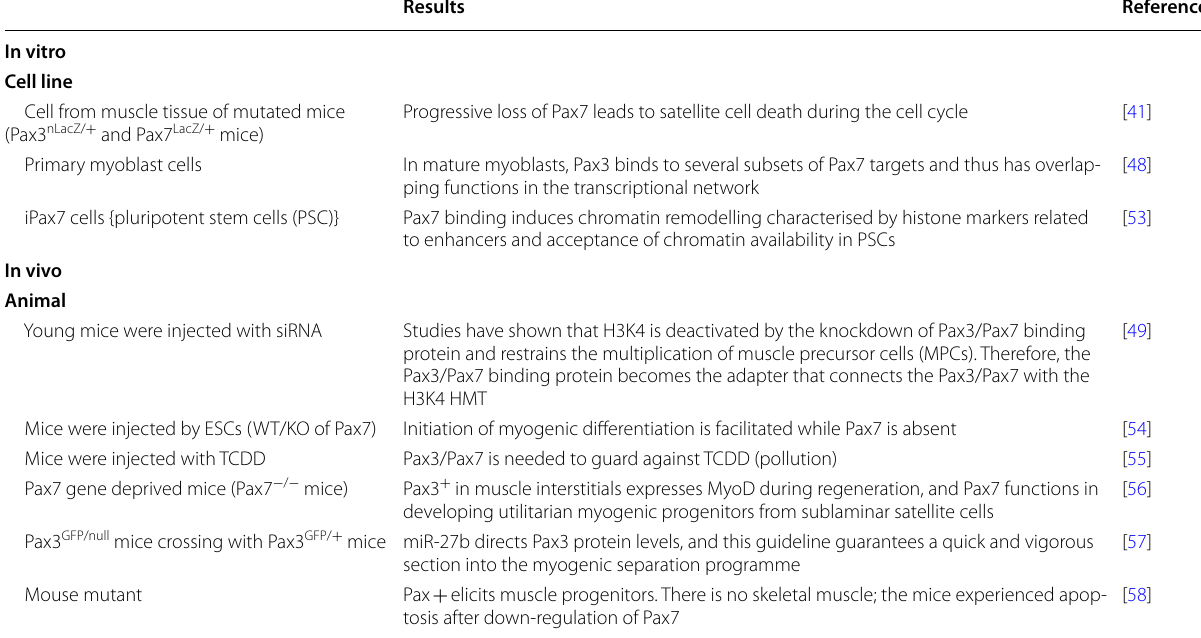
WT Wildtype, KO Knocked-out, TCDD 2,3,7,8-tetrachlorodibenzo-p-dioxin